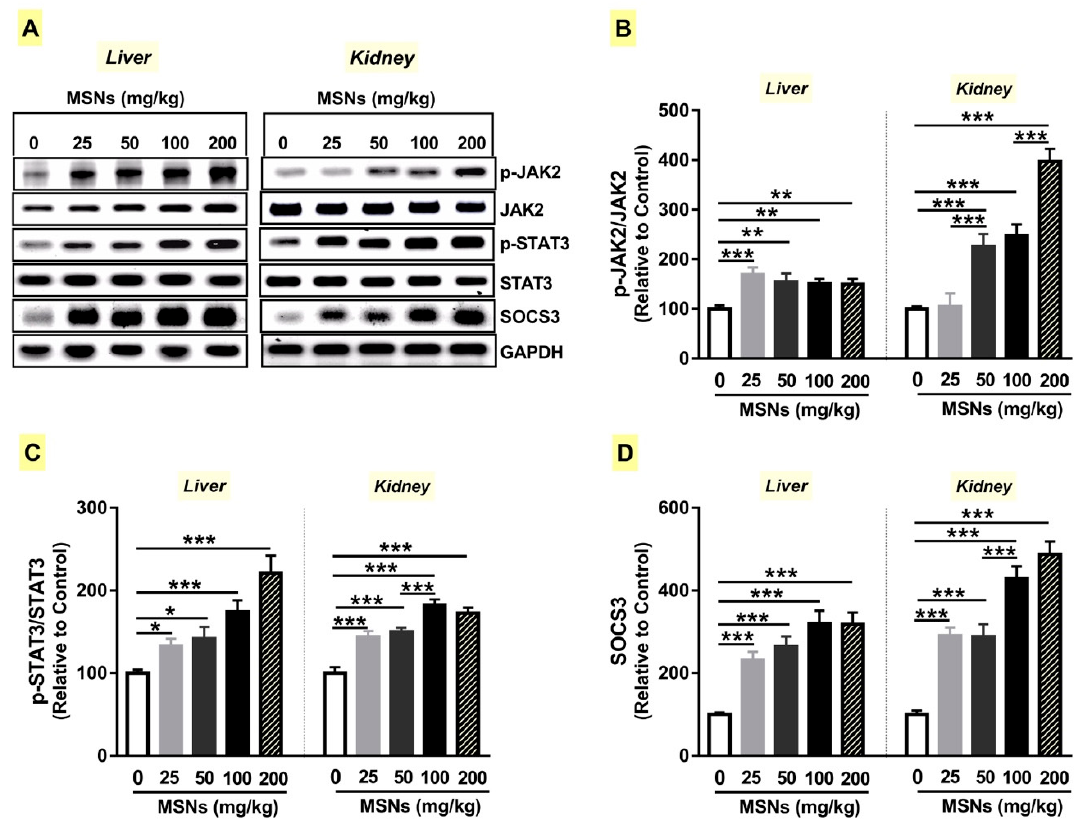
Figure 7. MSNs activate Janus kinase 2 / signal transducer and activator of transcription 3 (JAk2 / STAT3) signaling in liver and kidney of rats. ( A ) Representative blots of p-JAK2, JAK2, p-STAT3, STAT3 and SOCS3. MSNs increased phosphorylation levels of JAK2 ( B ) and STAT3 ( C ), and the expression of SOCS3 ( D ). Data are mean ± SEM ( n = 6). * p < 0.05, ** p < 0.01, and *** p < 0.001.